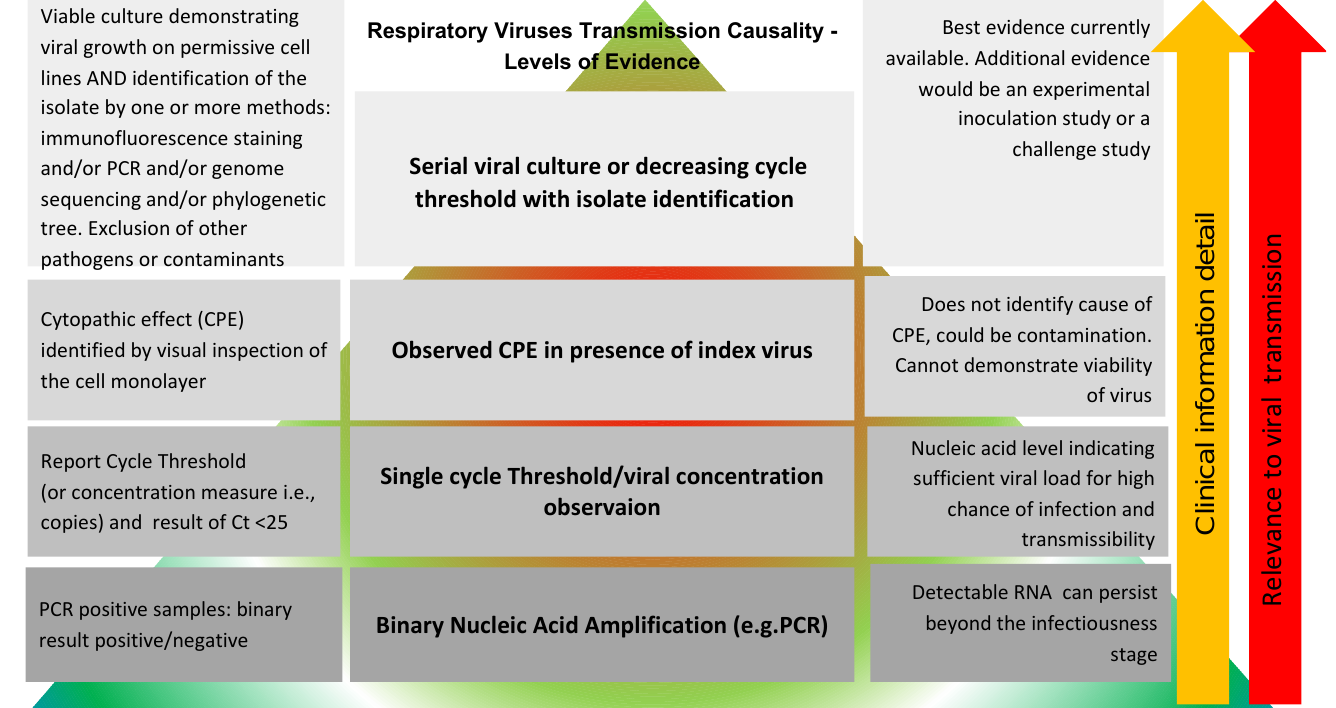
Figure 1. Levels of evidence for proof of the microbiological and clinical aspects of transmission of a viral respiratory pathogen. Decreasing cycle threshold over time refers to a validated surrogate marker. Key: CPE = cytopathic effect; PCR = polymerase chain reaction.